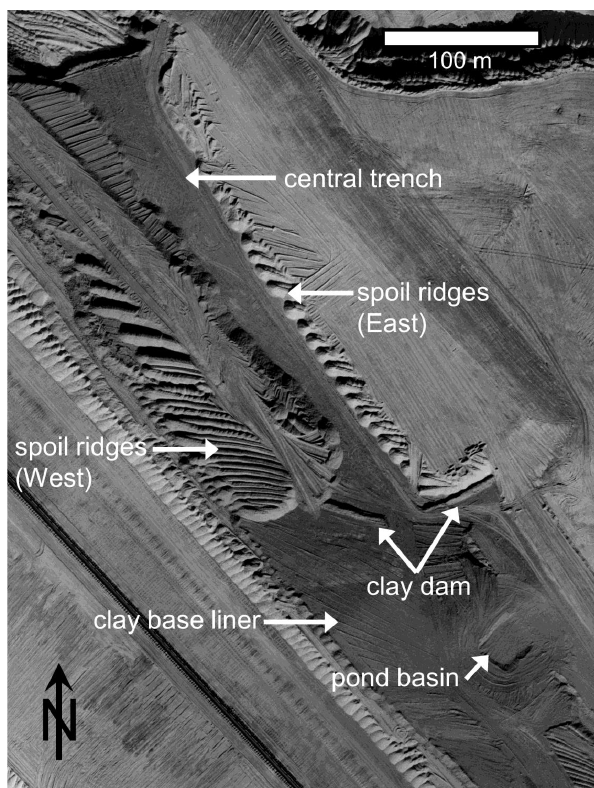
Figure 3. Aerial photograph (October 2004) showing the construction layout of the Chicken 2 Fig. 3. Aerial photograph (October 2004) showing the construction Creek catchment. Spoil ridges were digitised based on this image. 3 layout of the Chicken Creek catchment. Spoil ridges were digitised based on this